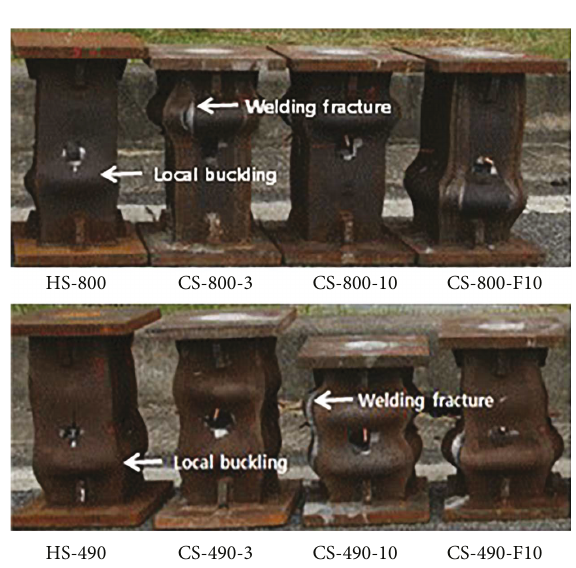
Figure 6: Failure of test